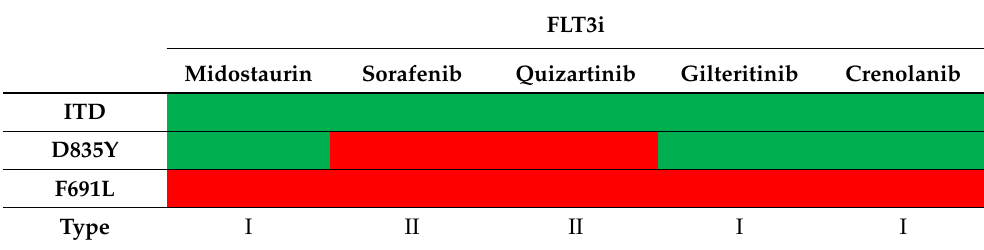
Table 2. FLT3i sensitivities for FLT3 D835Y and F691L